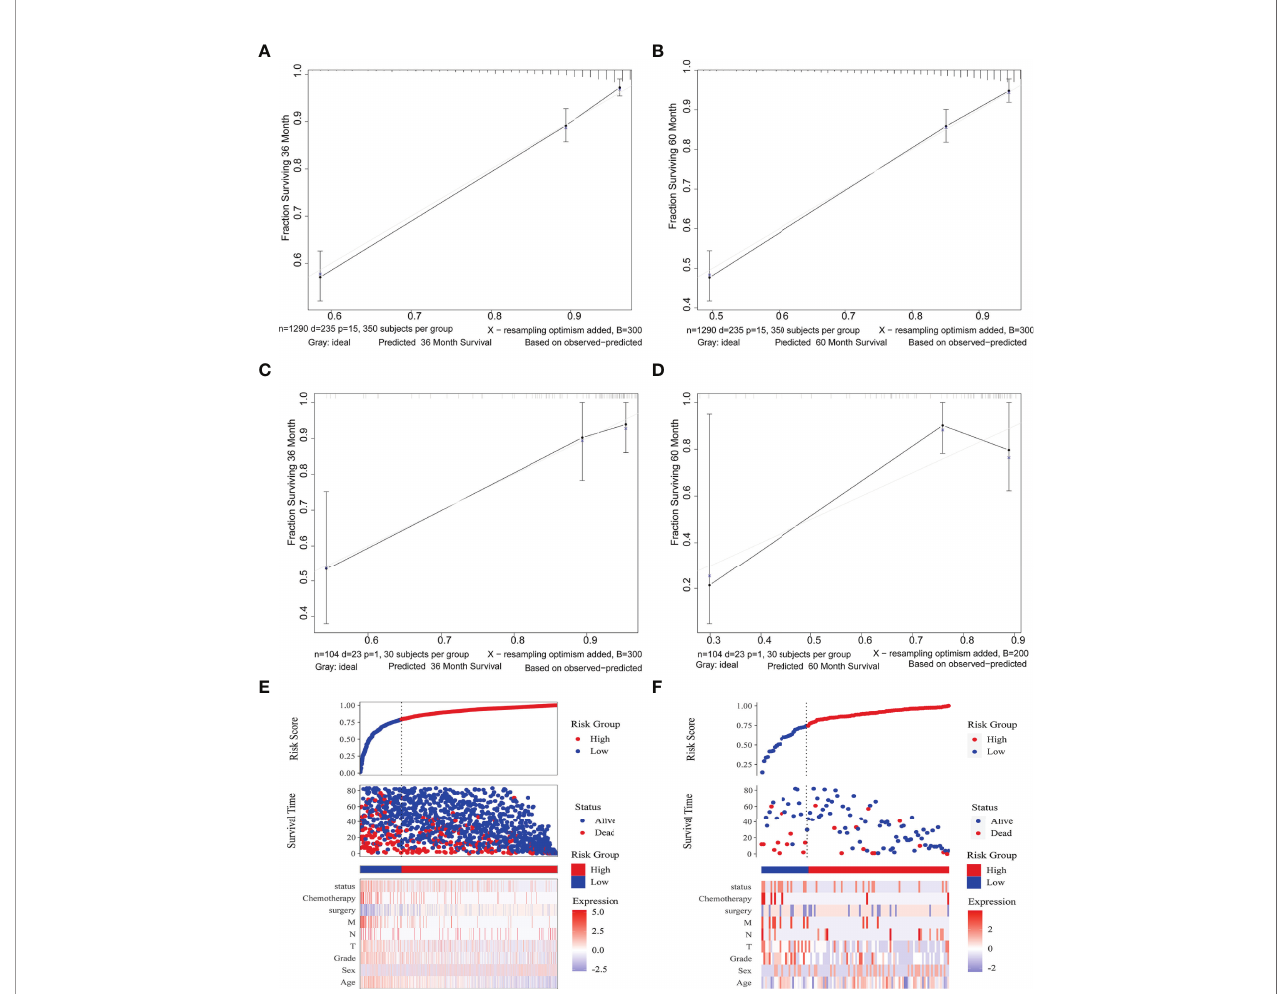
FIGURE 4 | Nomogram model validation. Calibration diagram for internal (A, B) and external (C, D) cohorts. The x/y axes represent the predicted risk proportion to actual incidence, respectively. Risk factor association plots for the training (E) and validation (F) groups, respectively. Top, plots of risk scores; middle, scatter plots of survival time and survival status for high and low risk; bottom, heat maps of key value of risk